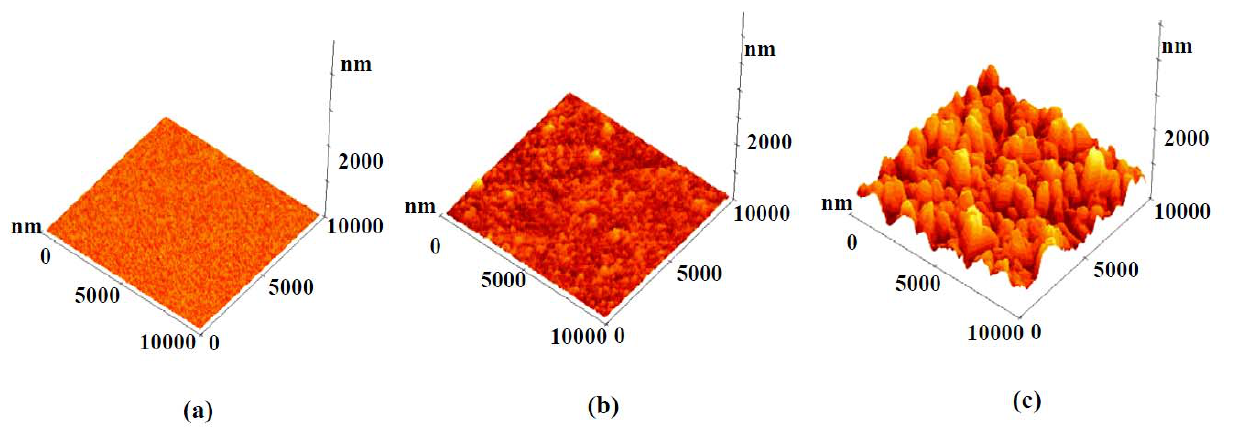
O 2 3 O coating. 2 3